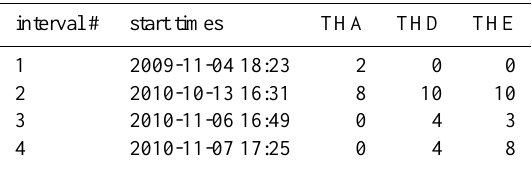
Table 2. Interval start times corresponding to magnetosheath data intervals of THA, THD, and THE with durations over one hour in which the IMF cone angle stayed below 30 ◦ . Counts of HSJ obser- vations by the respective spacecraft during these intervals are listed in the right three